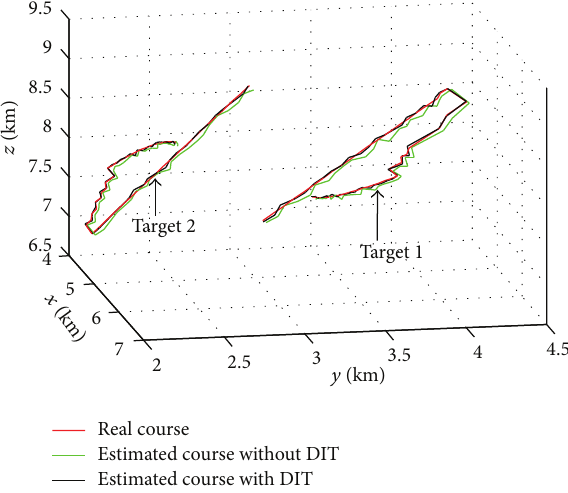
Figure 11: The moving target flight